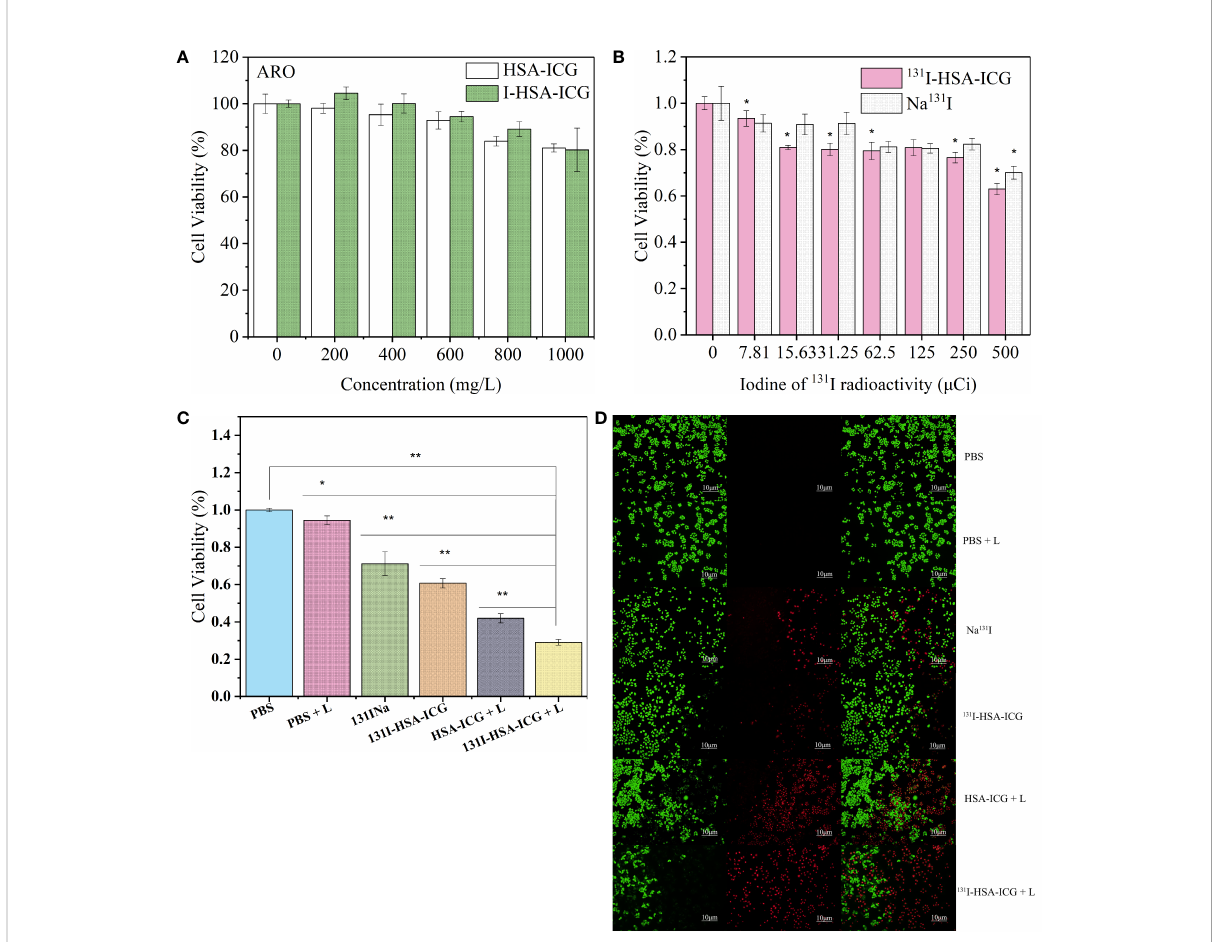
FIGURE 3 (A) Cell viabilities of ARO cells after treatment with different concentrations of HSA-ICG nanoparticles and I-HSA-ICG nanoparticles. (B) Cell viabilities of ARO cells after treatment with different radiation doses of Na 131 I and 131 I-HSA-ICG nanoparticles (C ICG = 10 ppm). (C) The survival rates of ARO cells in different treatment groups (C ICG = 10 ppm, 2.5 W/cm 2 ). (D) Live/dead cell staining pictures of different treatment groups obtained with a fl uorescence inverted microscope (C ICG = 10 ppm, 2.5 W/cm 2 ). L: 808-nm laser irradiation. HSA, human serum albumin; ICG, indocyanine green *, p < 0.05; **, p <